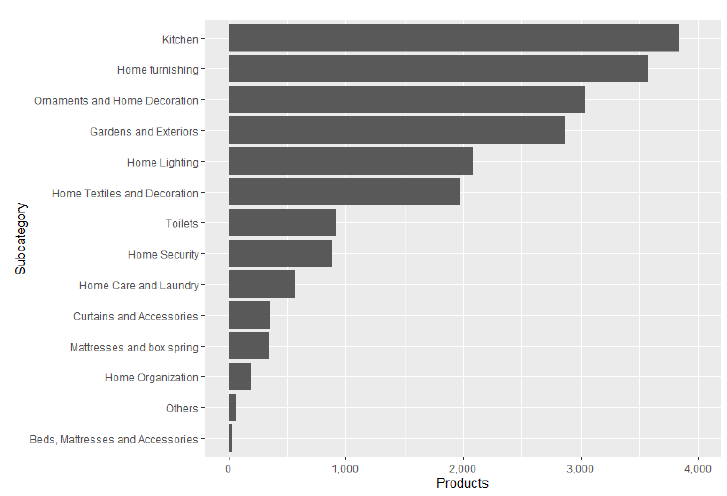
Figure A2. Number of products within the subcategories of Clothing, Bags, and Footwear .